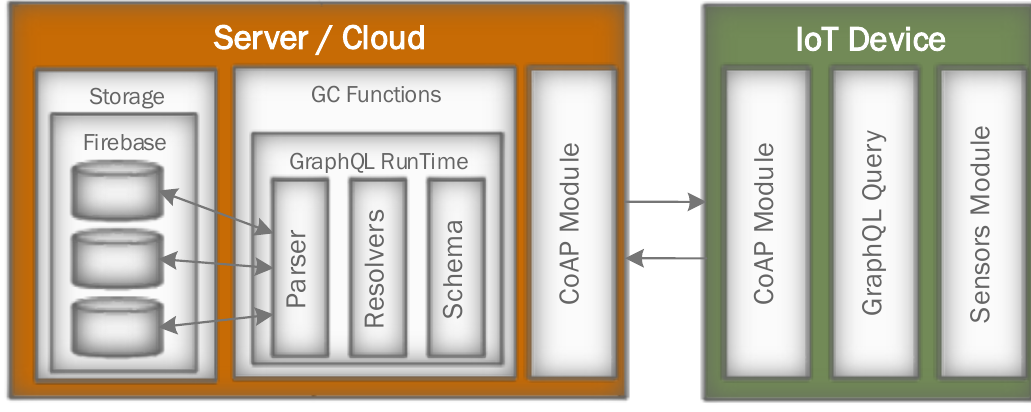
Figure 5. Components of the integrated framework on the client and server